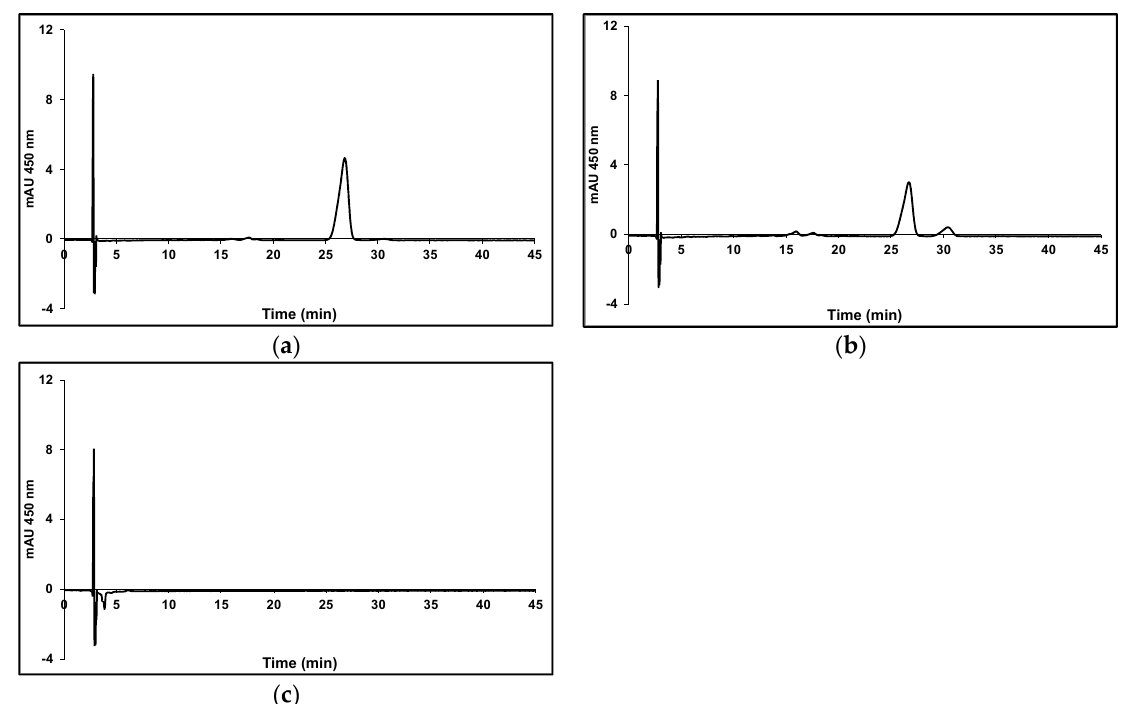
Figure 8. Effect of red or blue LED light on the photo-destruction of all-trans β C. All-trans β C was dissolved in chloroform to a final concentration of 2.4 µM and vials were thoroughly flushed with either nitrogen or air, sealed and incubated for 24 h at 25 ° C under different LED lights at 200 µmol m − 2 s − 1 . ( a ) Red light under nitrogen; ( b ) Red light in air; ( c ) Blue light in air.